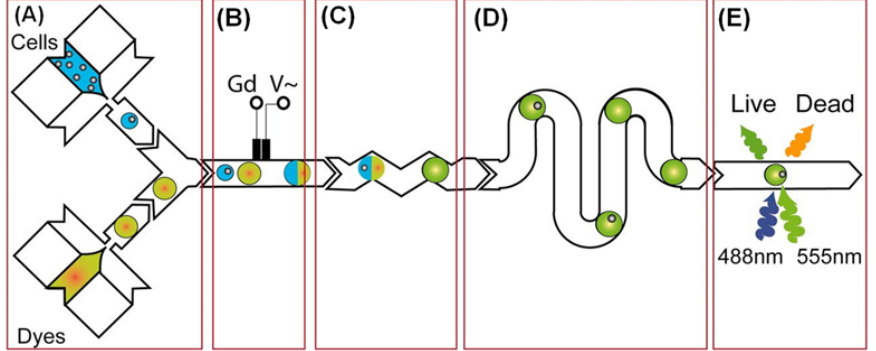
Figure 4. Schematic diagram of drug screening by Droplet Microfluidic Chip: ( A ) Inject droplets containing cells and fluorescent dye. ( B ) Droplet merging is controlled by electricity. ( C ) Mixing dyes with cells. ( D ) Optimize cell staining by extending channels. ( E ) Collect fluorescent signals. The image from [46], Copyright 2009, PNAS.